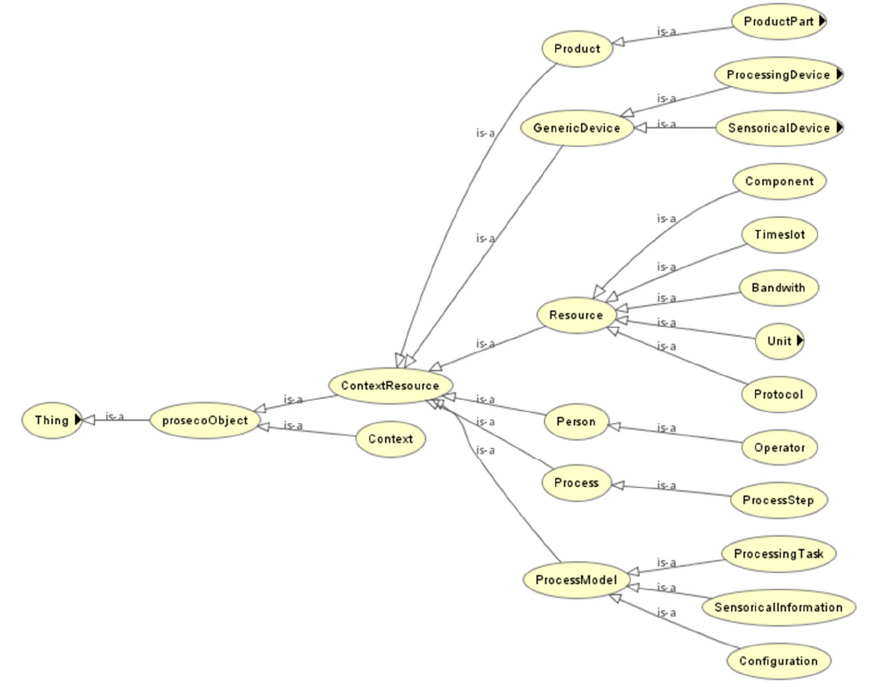
Figure 3. Context Model for device spaces.